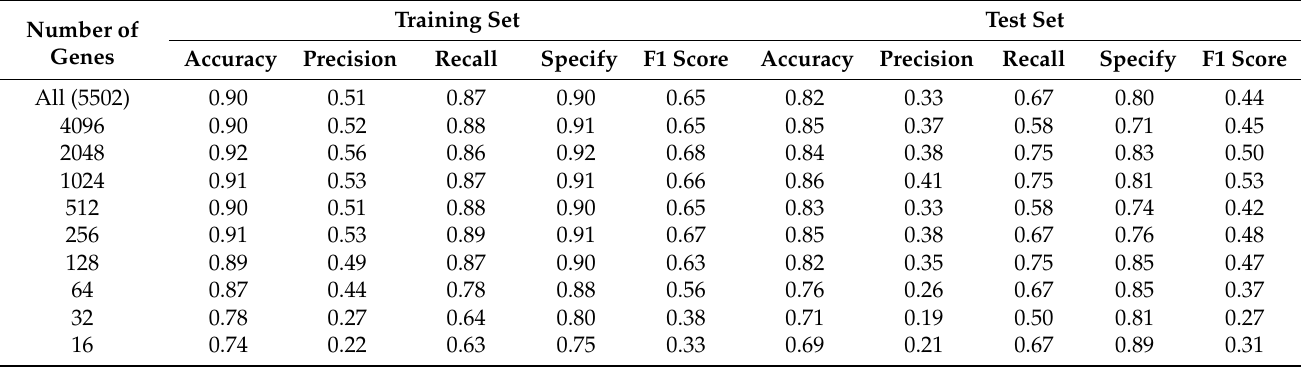
Figure 3. Average accuracy at varying levels of training sample and gene sizes of Support Vector Machines (SVM) method. The x -axis represents the top number of genes, and the y -axis represents the average accuracy. The top and bottom of the box are the 75th and 25th percentiles, respectively. The top and bottom bar are the maximum and minimum value. The circles are the outliers. Table 3. SVM classifier trained on SVM genes obtained with the DE